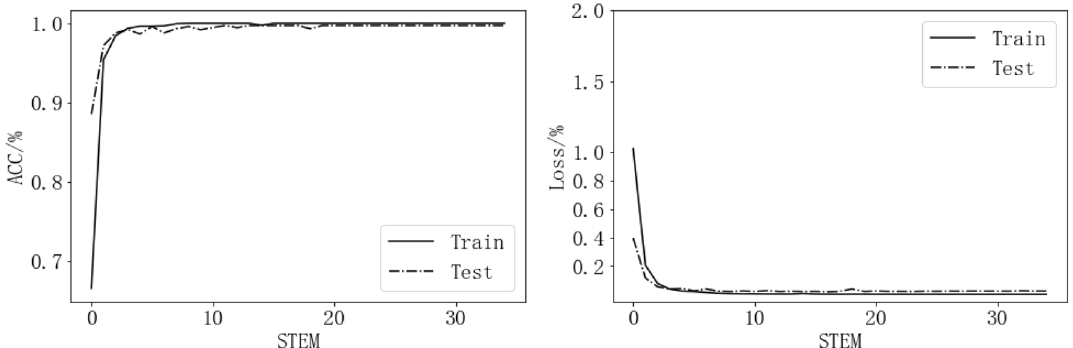
Fig. 5 Accuracy and Loss of IC-CNN model